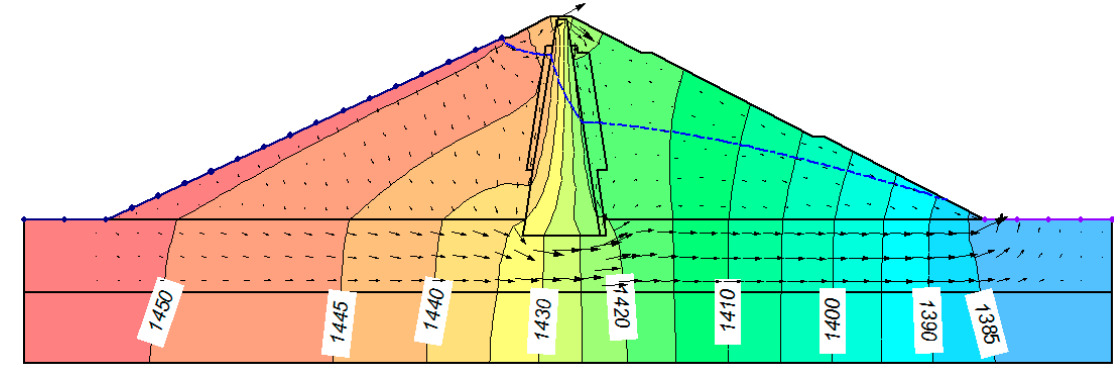
Figure 3. Water surface and equipotential lines.